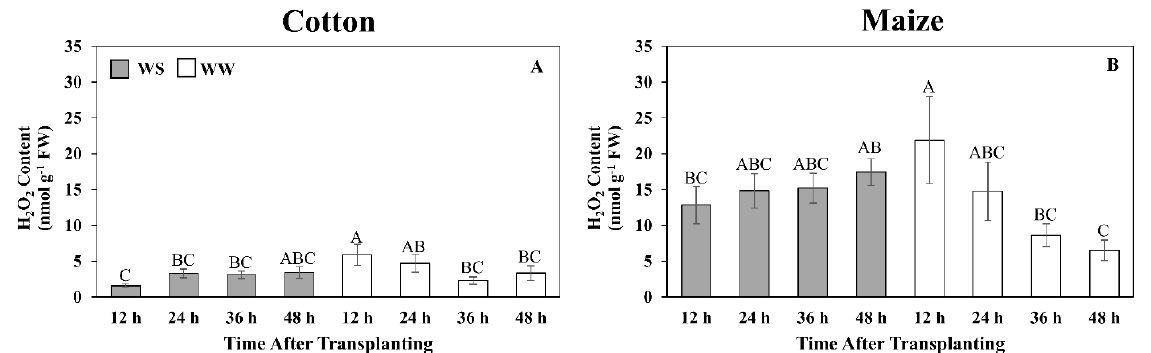
Figure 7. Time courses of hydrogen peroxide (H 2 O 2 ) content in the elongation zone of cotton ( A ) and maize ( B ) primary roots during 48 h after transplanting to water-stressed (WS, shaded bars) or well-watered (WW, open bars) conditions. In the water stress treatments, vermiculite water potentials were − 1.0 MPa (cotton) and − 1.6 MPa (maize), which resulted in equivalent root tip water potentials in the two species (Figure 2). The whole elongation zone was collected (see Figure 6 for dimensions). Data are the means ± SE ( n = 6). ANOVA analyses compare the data at different time points across treatments within each species; different letters indicate significant differences ( p < 0.05).